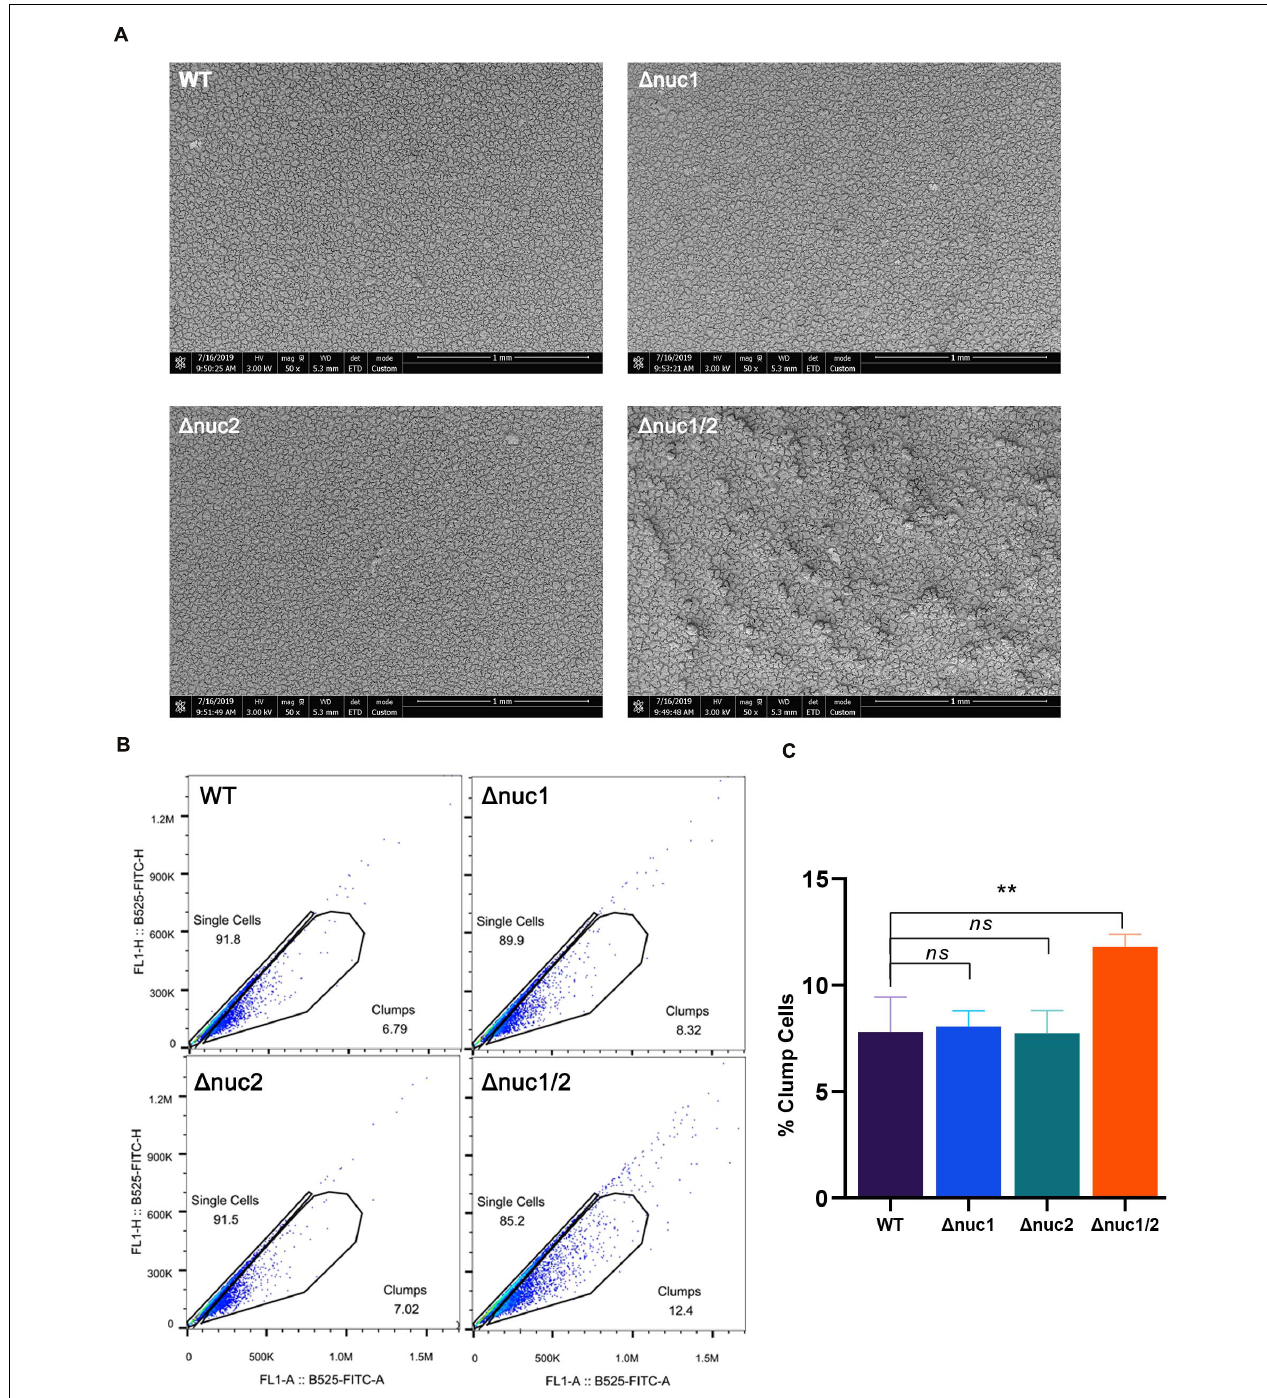
FIGURE 5 | Role of nuc1 and nuc2 on bacterial aggregation and biofilm structure in vitro . (A) Biofilm formed by ST1792 and its isogenic mutant on titanium disk observed with SEM (scale bar = 1 mm). (B) Flow cytometry was used to determine bacterial aggregation. (C) Quantification result for the flow cytometry experiment. Statistical significance was calculated using ANOVA with Dunnett multiple column comparisons. n = 3/group. ** p < 0.01 vs. WT.